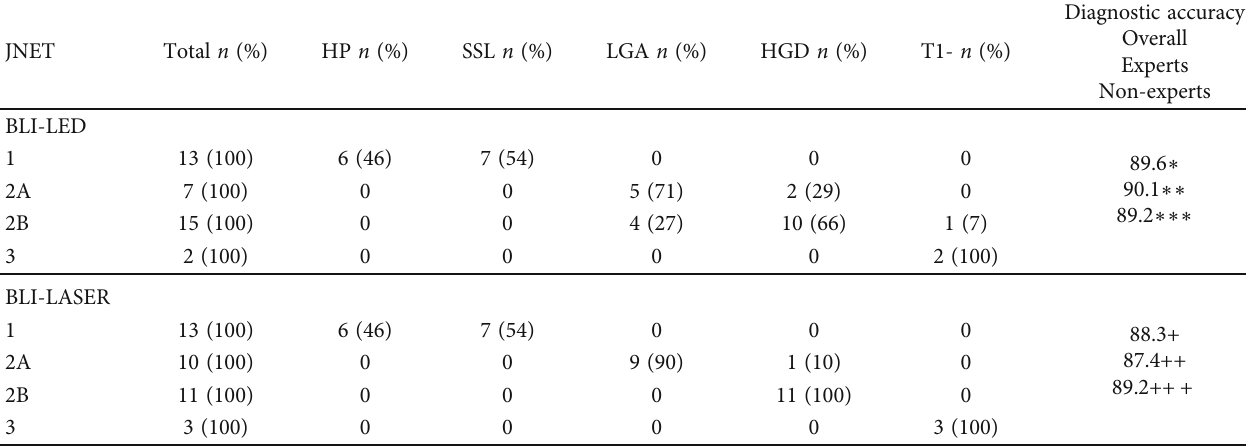
Table 2: The comparison of the tumor characteristics using JNET classi fi cation between BLI-LED and BLI-LASER. JNET